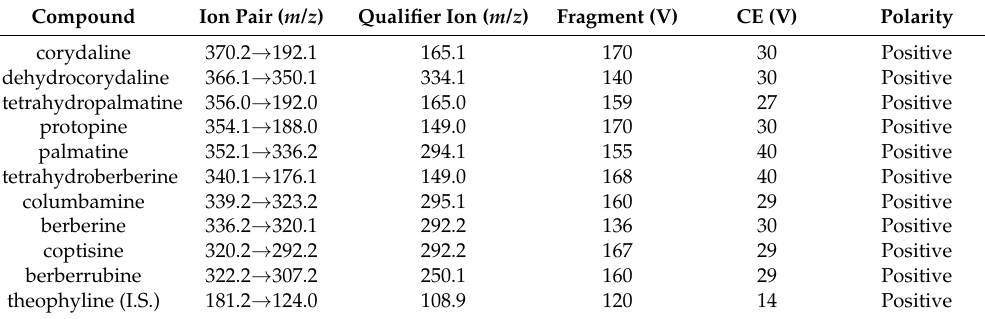
Table 6. Quantitative, Qualifier ions and MS parameters of eight alkaloids and